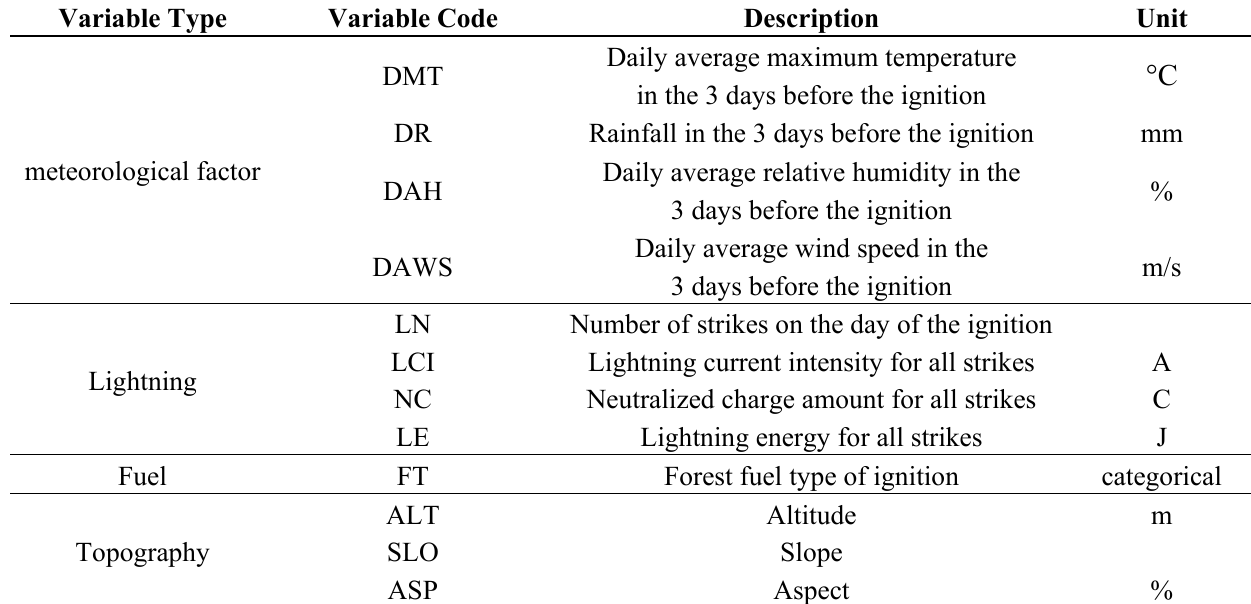
Table 1. Candidate variables for predicting the probability of lightning fire occurrence in area of Daxinganling Mountains,